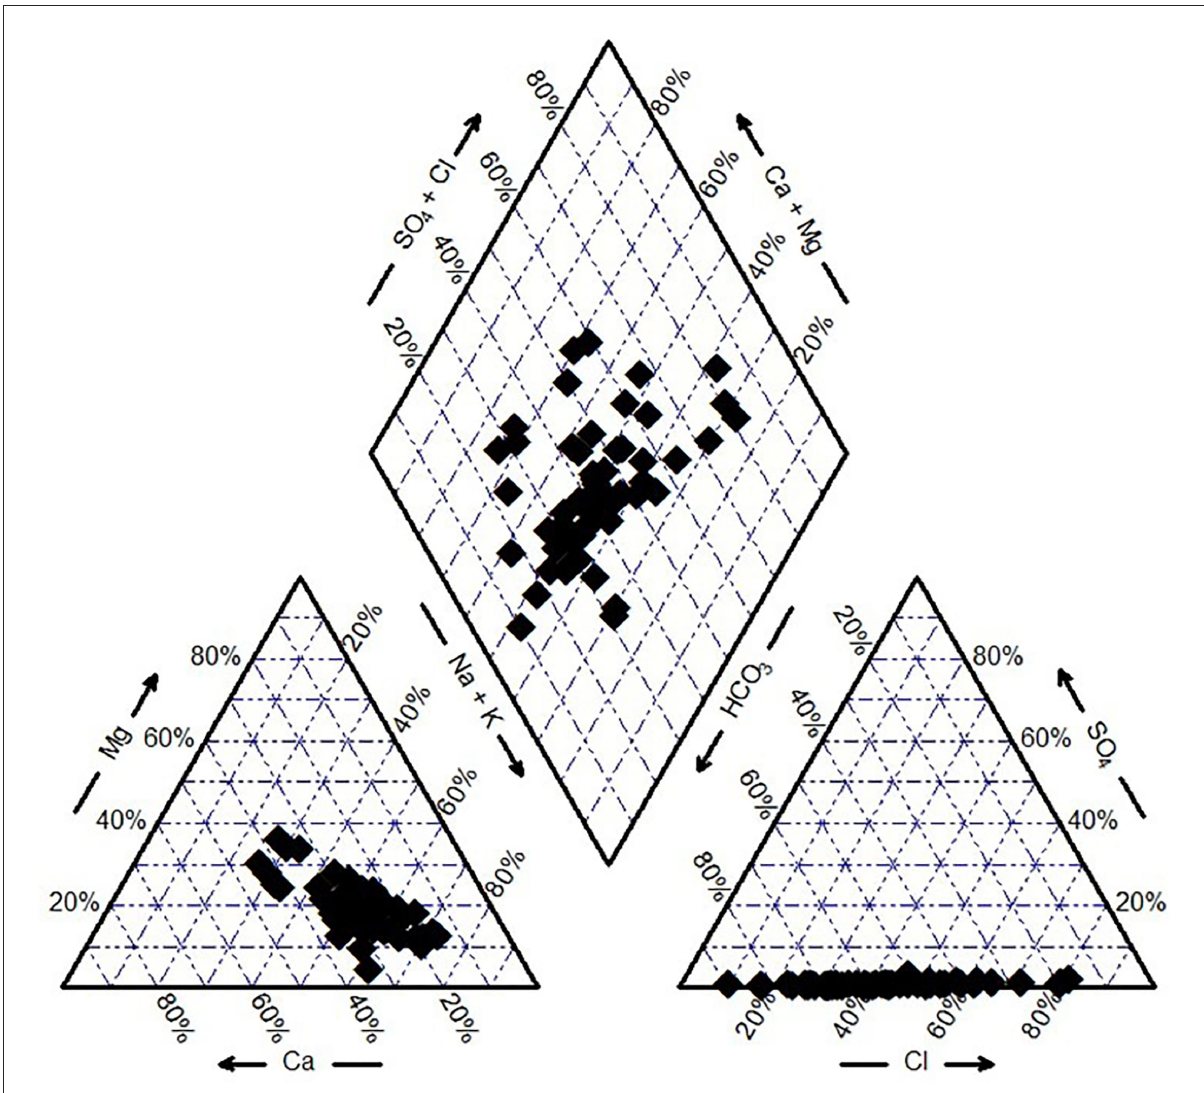
FIGURE3 Piper diagram delineating the hydro-chemical facies of the study